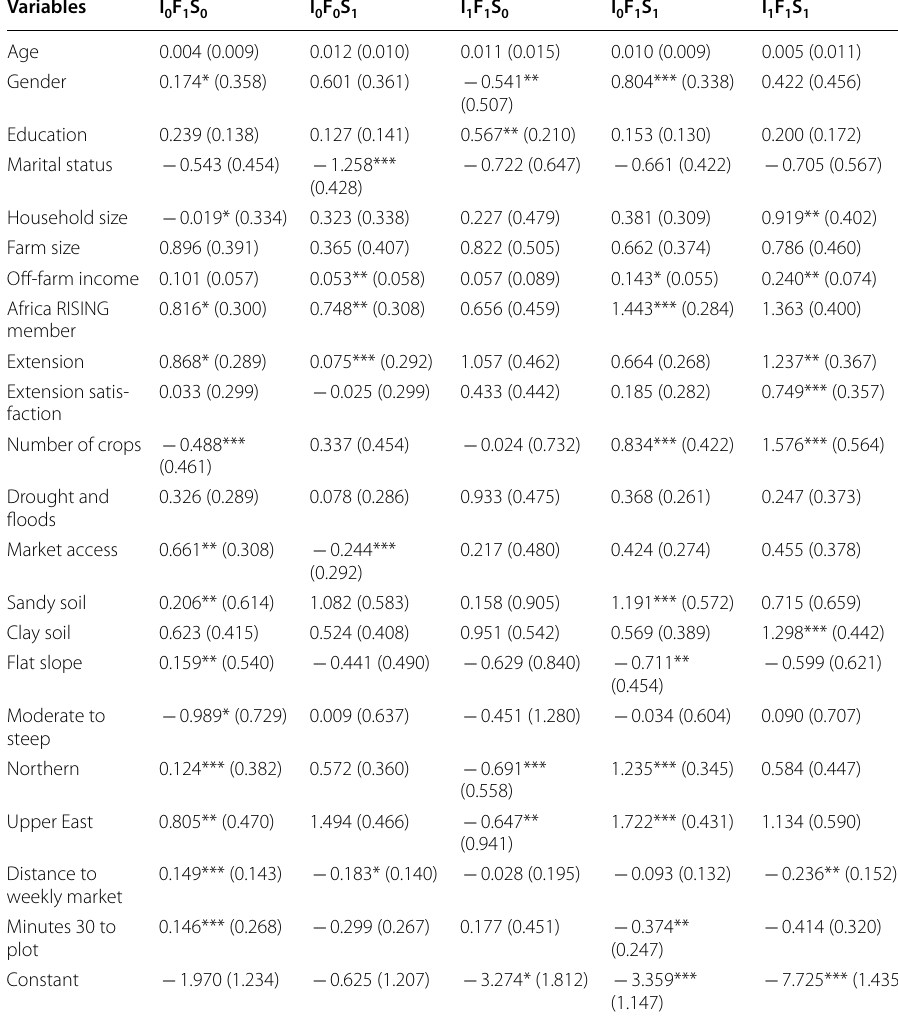
Table 3 MNL estimates of SAP